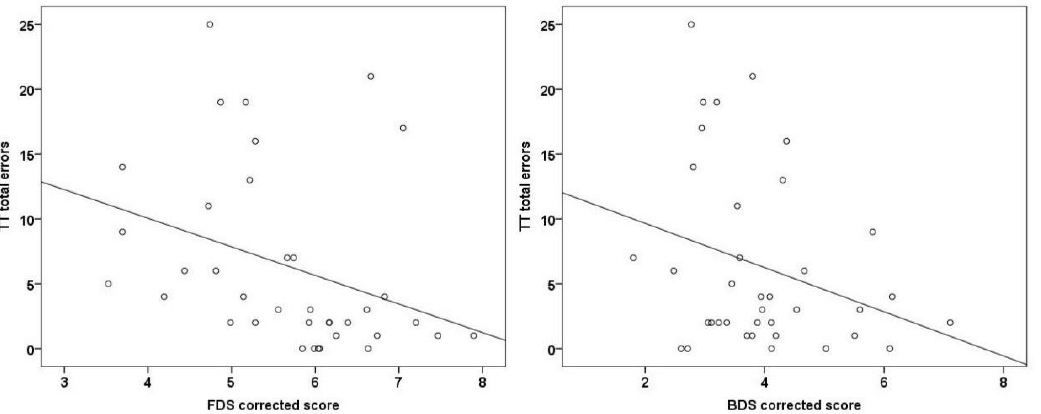
Figure 1. Distribution of Token Test (TT) total errors according to the corrected score obtained in the Forward (FDS) and Backward (BDS) Digit Span test. The solid black line represents the line of best fit. When the association between the number of TT total errors and the lesion location was investigated, no significant differences were observed ( p = 0.485) in the number of errors according to the lesion site. Similarly, no significant difference was found in FDS ( p = 0.629) and BDS ( p = 0.568) corrected scores between participants with subcortical, lobar, or other lesion